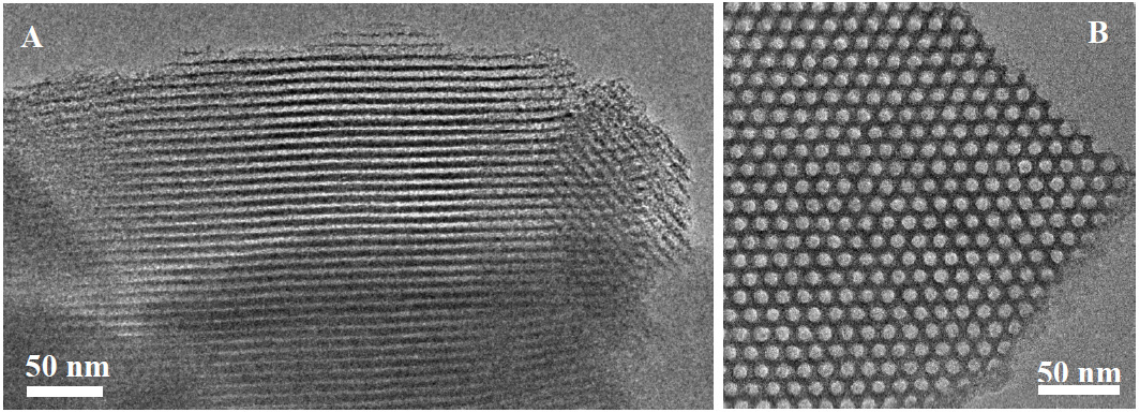
Figure 2. TEM images of calcined SBA-15-L in the direction perpendicular to the pore axis ( A ) and SBA-15-S in the direction of the pore axis ( B ).